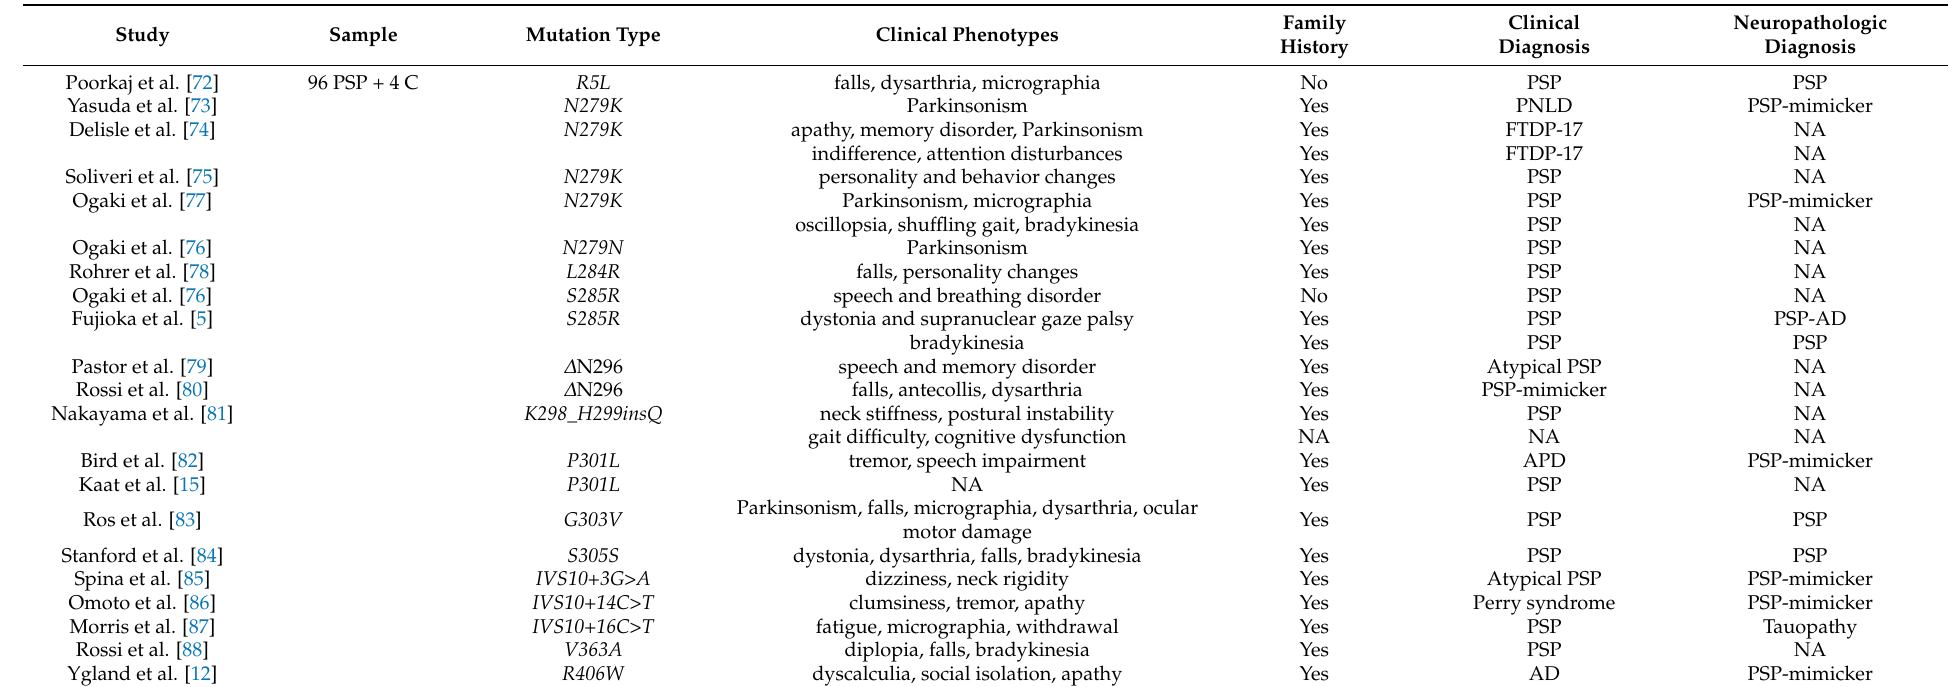
Table 3. MAPT mutations causing PSP-like